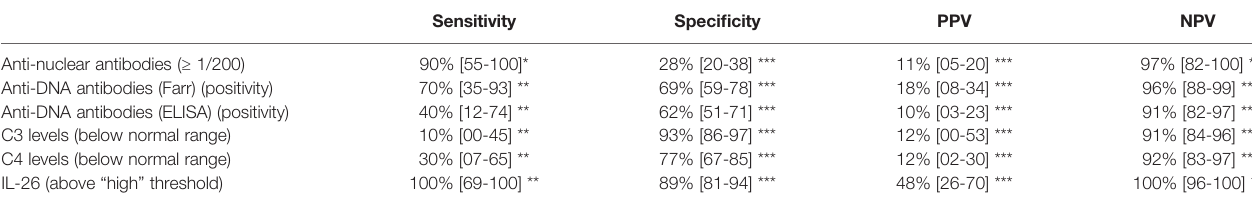
P-values of the comparison of sensitivities, speci fi cities, PPV and NPV for each classical marker (versus IL-26) are depicted by stars (* < 0.05, ** < 0.01, *** < 0.001). PPV, positive predictive value; NPV, negative predictive